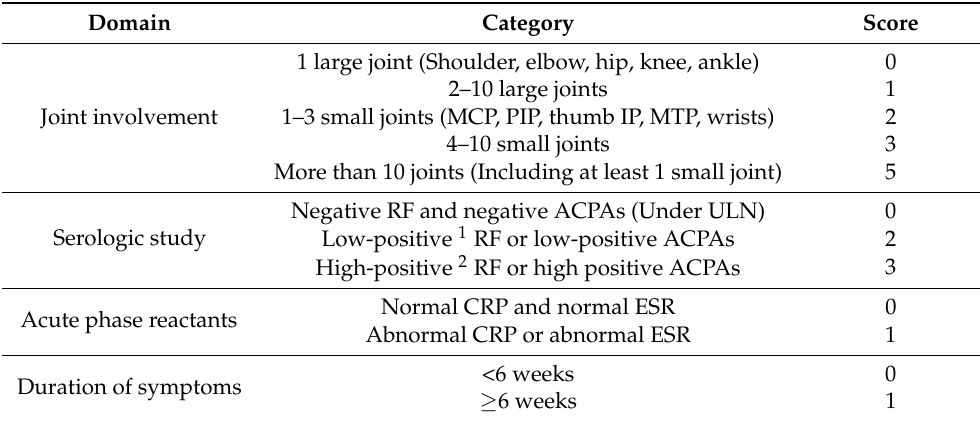
Table 1. Scoring for rheumatoid arthritis (RA)